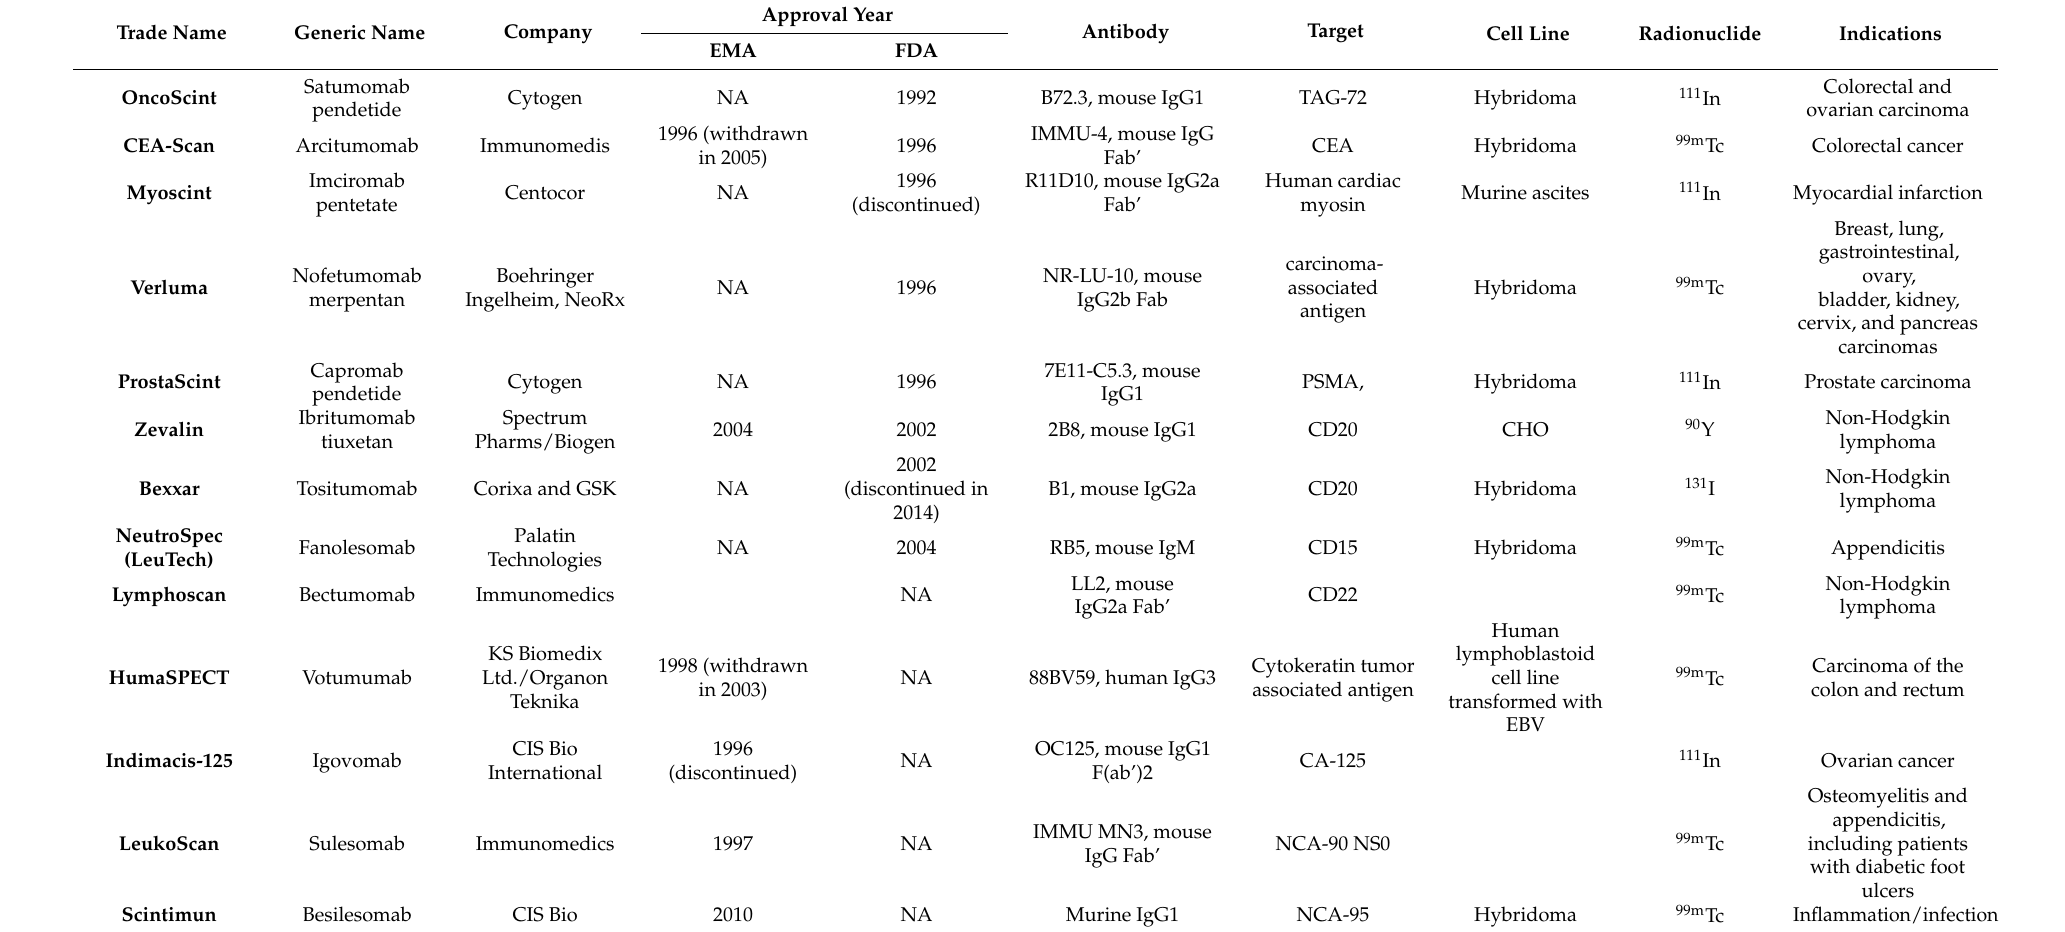
Table 1. Radioimmunoconjugates that are approved by FDA and